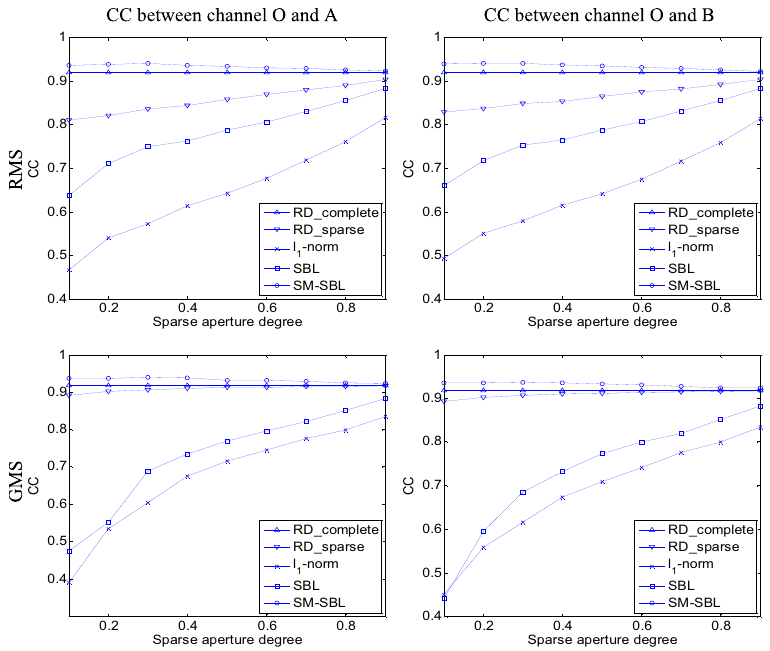
Figure 8. Comparison of correlation coefficients (CC) of multi-channel inverse synthetic aperture radar (ISAR) images under different sparse aperture (SA)